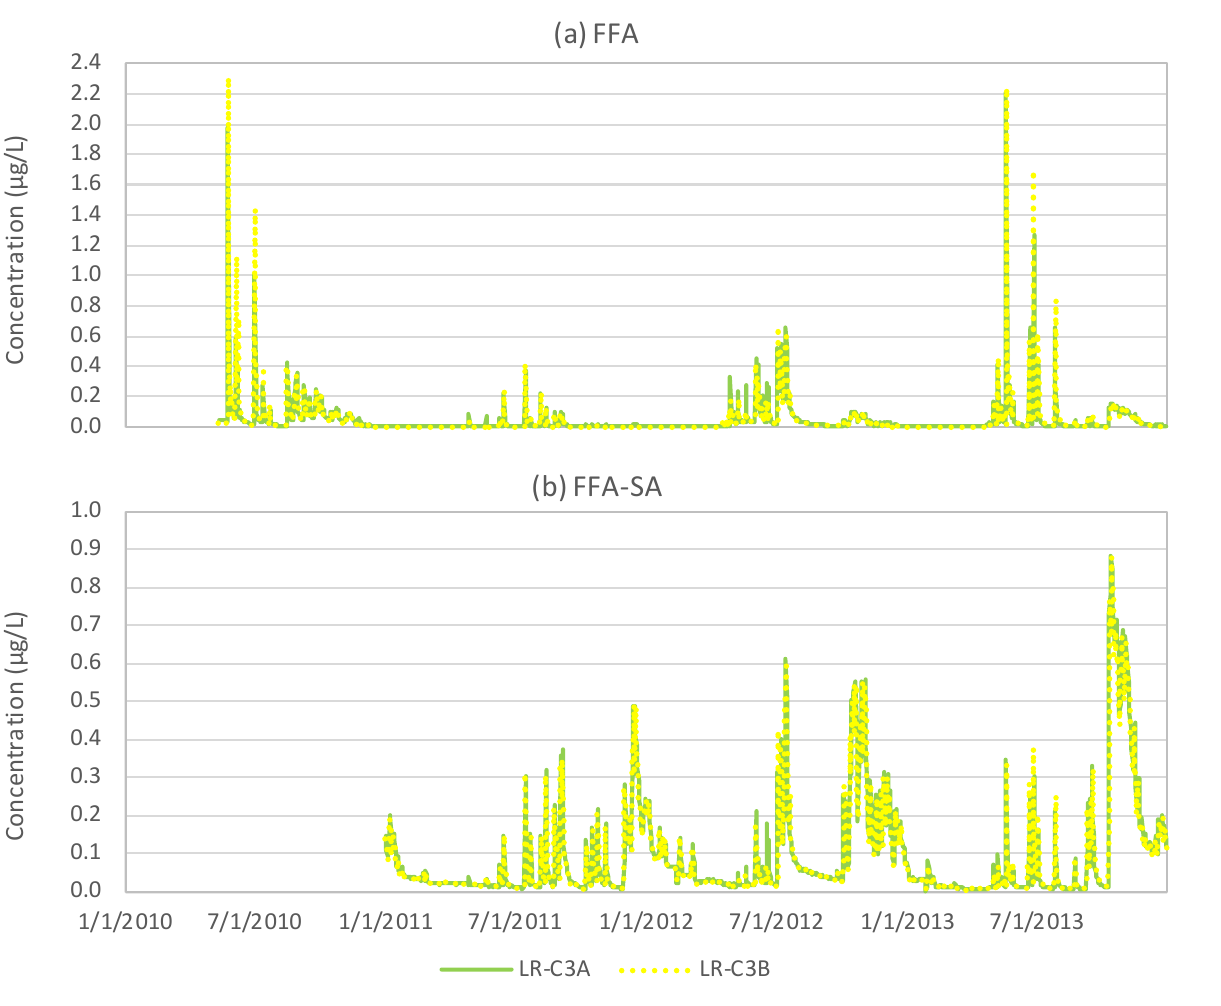
Figure 6. Comparison of simulated ( a ) FFA and ( b ) FFA-SA concentrations from conditional simulations using actual PCT (LR-C3A) with an actual application rate and assuming 100% PCT with a PCT adjusted application rate (LR-C3B).